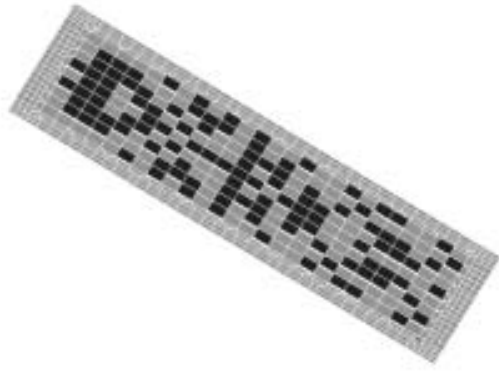
Fig. 10. Optimized panel’s F.E. model.